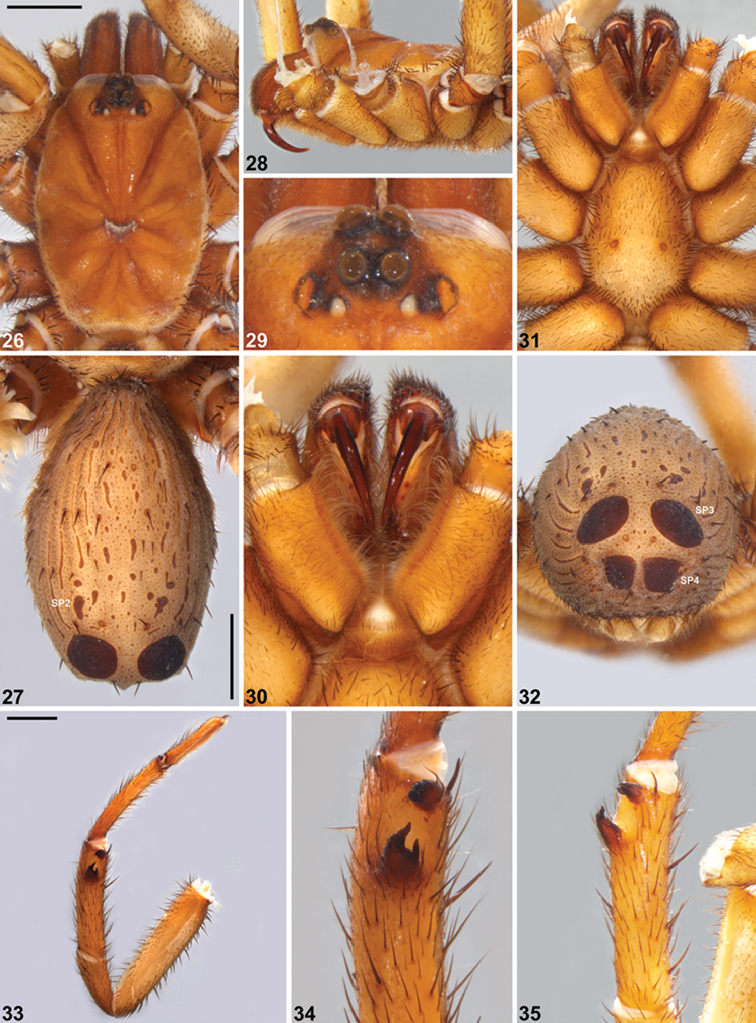

Idiosoma
nigrum Main, 1952, male (WAM T3301) from Walk Walkin, via Koorda (Western Australia; AVW), somatic morphology. 26–27 Carapace and abdomen, dorsal view 28 Carapace, lateral view 29 Eyes, dorsal view 30 Mouthparts, ventral view 31 Sternum, ventral view 32 Abdomen, posterior view 33 Leg I, prolateral view 34 Leg I tibia, clasping spurs, prolateral view (note loss of clasping spur macroseta) 35 Leg I tibia, proventral view. Scale bars 2.0. SP2–4 = sigilla pairs 2–4.